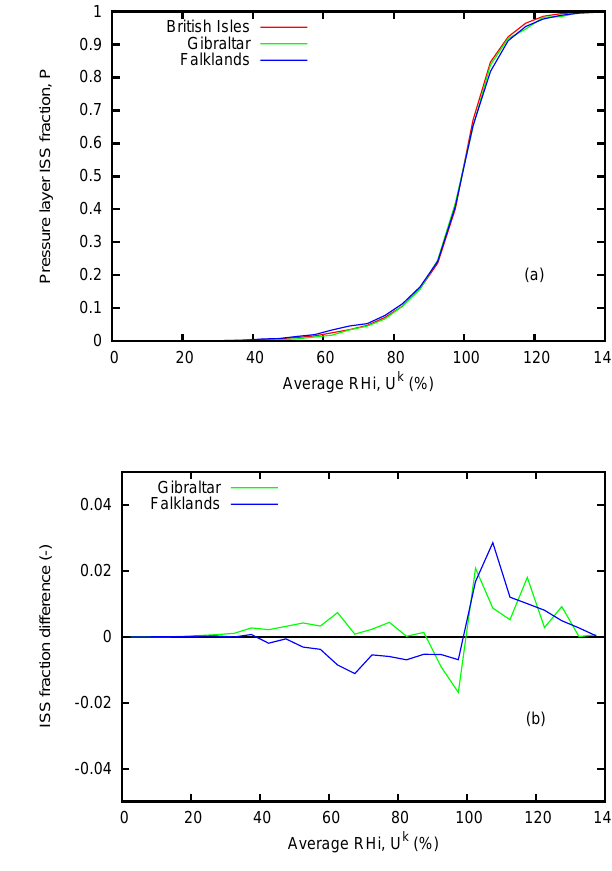
Fig. 10. The relationship between average RHi and the ISS fraction within 50-hPa pressure layers, comparing individual seasons is shown in panel (a) . The differences between them and the British Isles average curve are shown in panel (b) . These data are derived from six high resolution radiosonde launch stations within the British Isles (January 2002–December 2006).